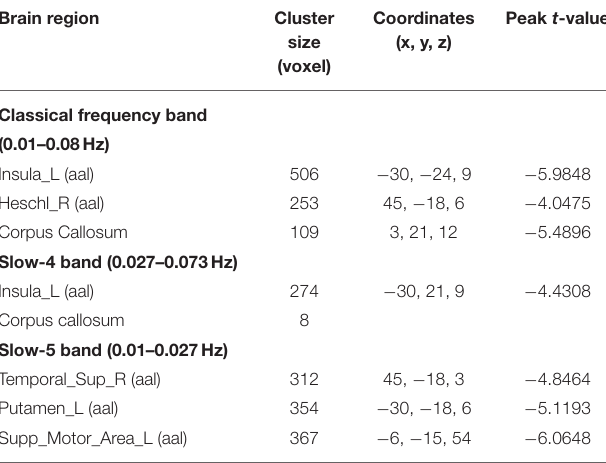
TABLE 2 | Brain regions with alteration of ReHo after cerebellar